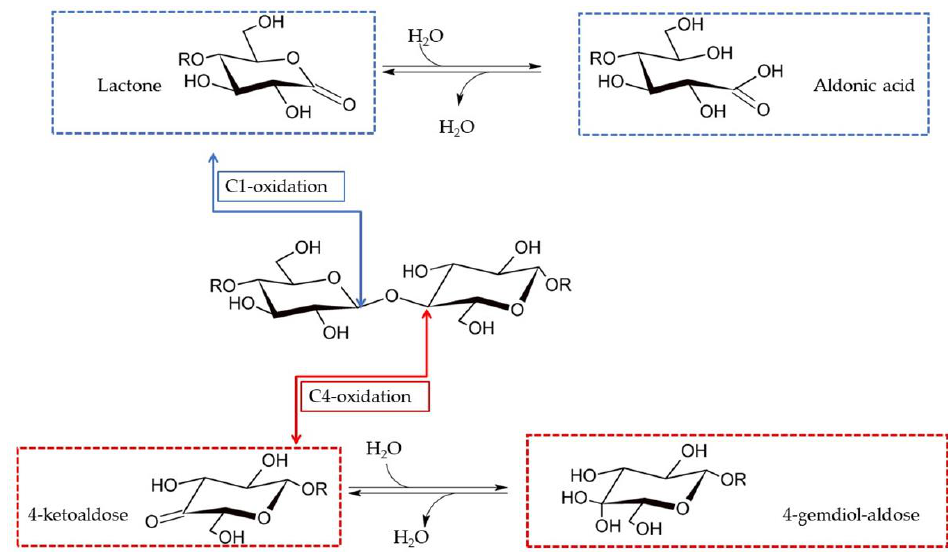
Figure 3. LPMO activity on cellulosic substrates. Oxidation can occur either at the C1 or C4 positions, leading to the formation of a lactone or a 4-ketoaldose, respectively.